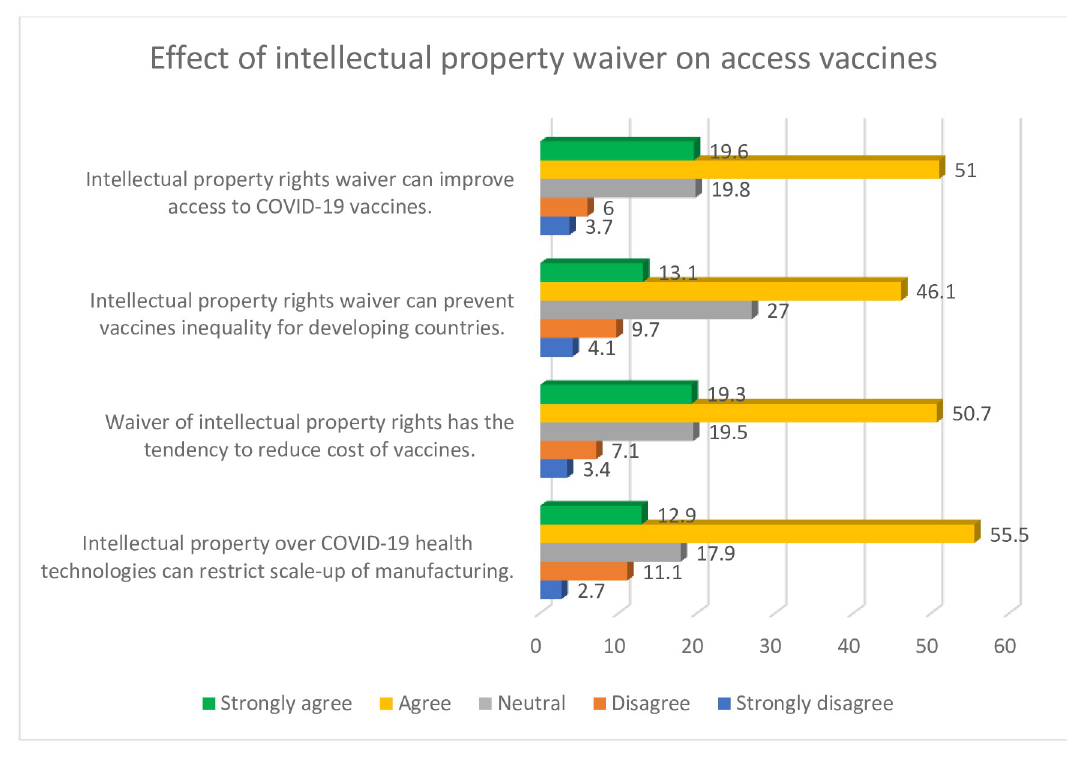
Fig 2. Role of intellectual property on access to